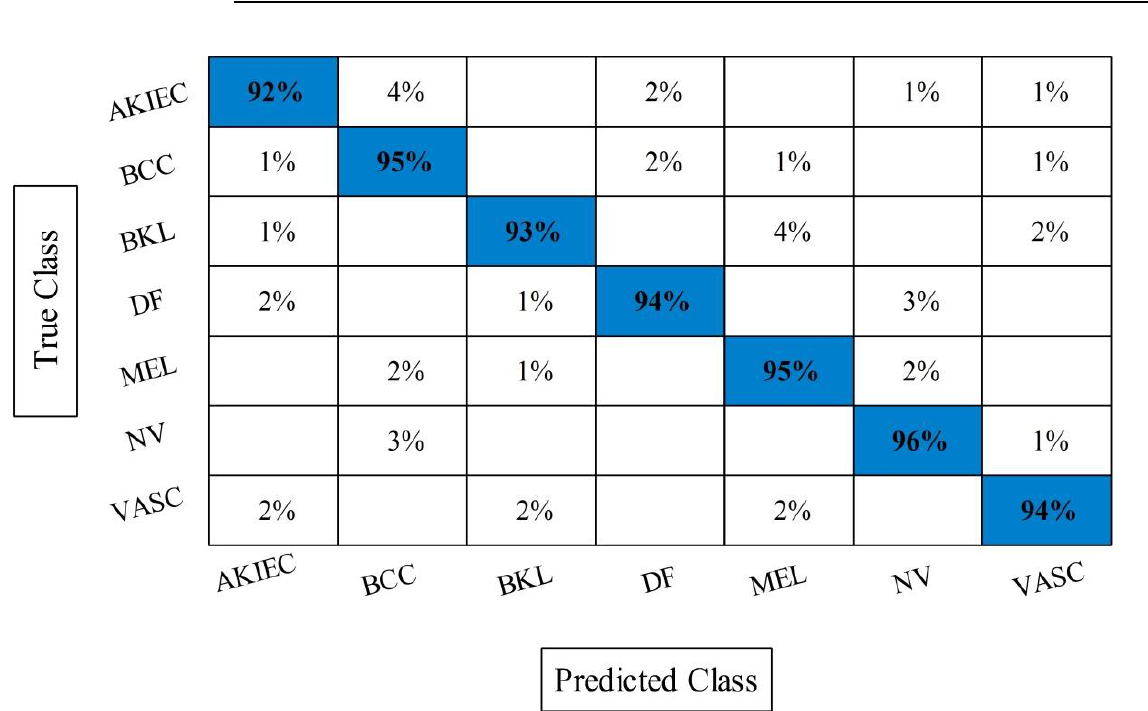
Figure 11. Confusion matrix of ELM after best selected features fusion for ISIC2018 dataset.